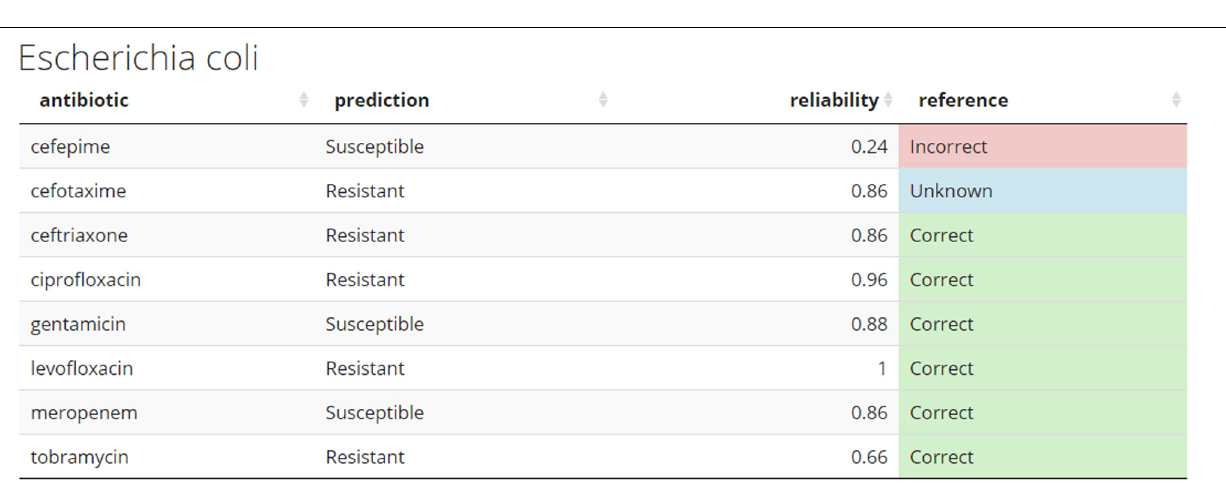
FIGURE 5 | Distribution of reliability indexes (RI). Density plots are based on the predictions of the respective testing sets for each final model.